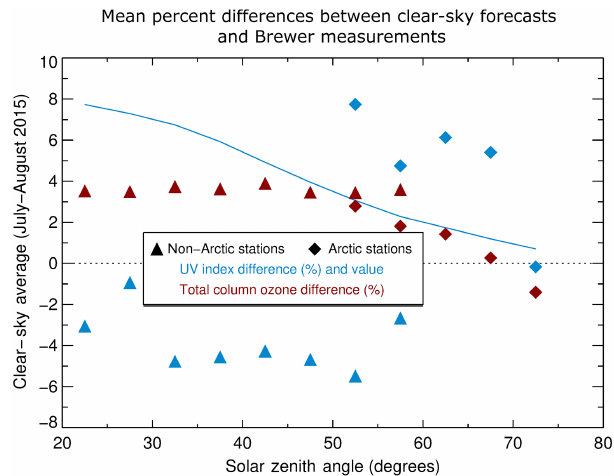
Figure 11. Average UV Index and total column ozone relative dif- ferences between the model forecasts and Brewer measurements as a function of solar zenith angle for daytime clear-sky to lightly cloudy conditions for both sets over July and August 2015. This is accompanied by the corresponding average UV Index values. The averages are over 5 ◦ intervals in solar zenith angles over the two Arctic stations (Eureka and Resolute) and four non-Arctic stations (Churchill, Edmonton, Saturna, and Toronto) of Fig. 4. The resul- tant numbers of averaging points per bin range from 30 to 1002 with statistical outliers having been removed in final averages. Model forecasts with output for station locations every 7.5min were gen- erated from weather and ozone analyses for 00:00 and